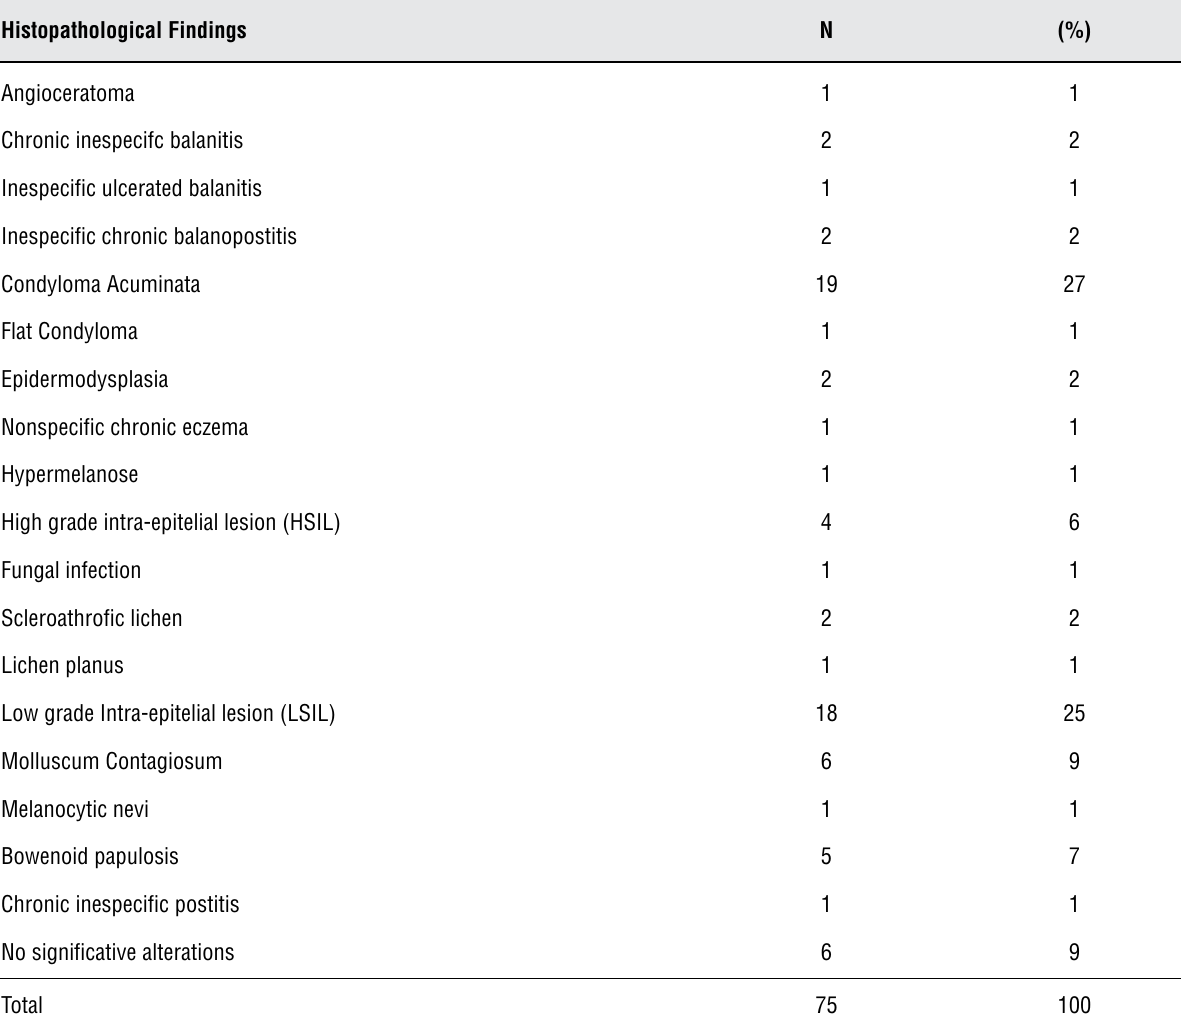
Table 5 - Distribution of histopathological findings of patients with clinical lesions detected. Histopathological findings